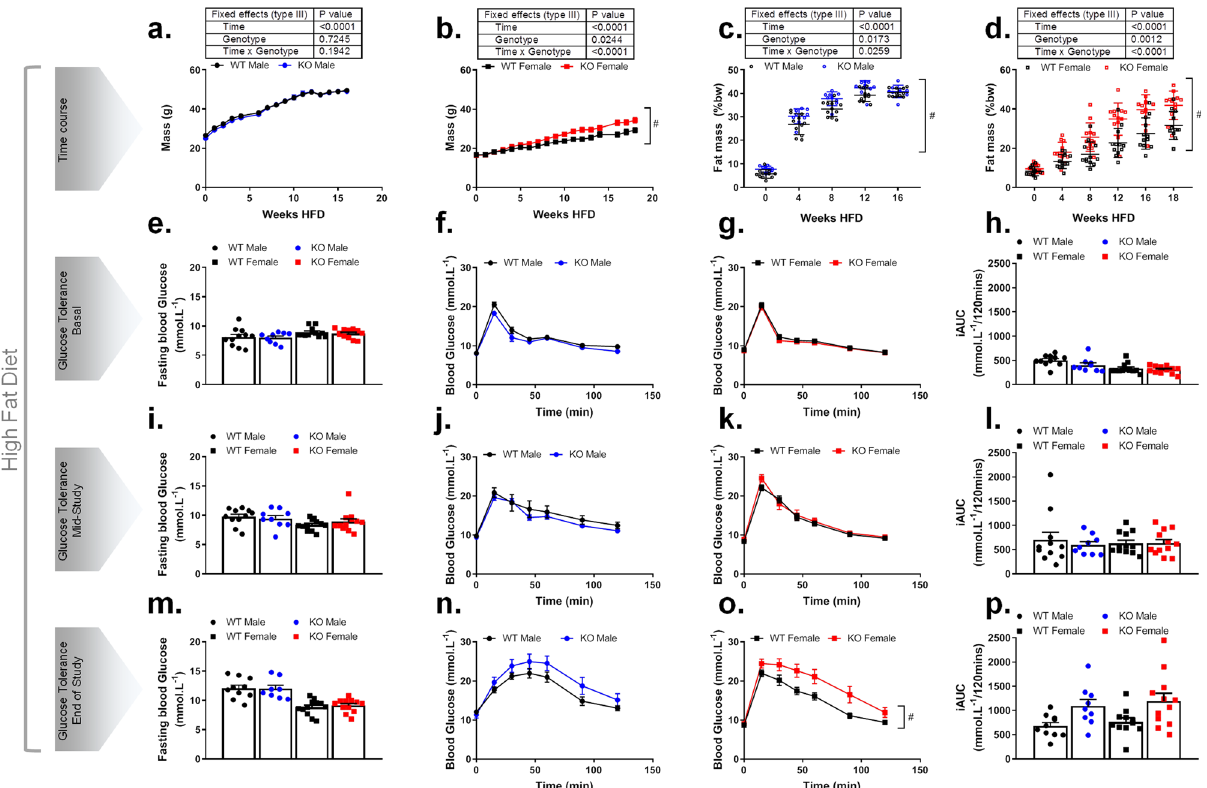
Fig. 3 Trim28 adi-KO increases adiposity in mice fed a high-fat diet. Trim28 wild type (WT) and adipose-speci fi c Trim28 KO (KO) male and female C57BL/6 J mice were maintained on a high-fat diet (HFD) for 16 weeks from 6 weeks of age. Whole body adiposity measures including body mass and fat mass presented as percent body weight (BW) for ( a , c ) male mice and ( b , d ) female mice from 6 weeks of age at the commencement of HFD. Fasting blood glucose and oral glucose tolerance test in male and female mice with corresponding incremental area under the curve (iAUC) after 0 weeks of HFD ( e – h ; basal), 4 weeks of HFD ( i – l ; mid-study), and 16 weeks of HFD ( m – p ; end of study). All data are presented as mean ± SEM, female mice n = 12 WT and n = 12 KO, and male mice n = 11 WT and n = 9 KO. All data were analyzed using two-way ANOVA where * p < 0.05, or repeated measures mixed-effects model where # p < 0.05 for time × genotype Fig. 4B and Supplementary Fig. 4G to Supplementary Fig. 4H, respectively) and EE (Fig. 4e, m) were observed across the light and dark periods; however, no signi fi cant differences were observed between male Trim28 WT and adi-KO mice on either diet.